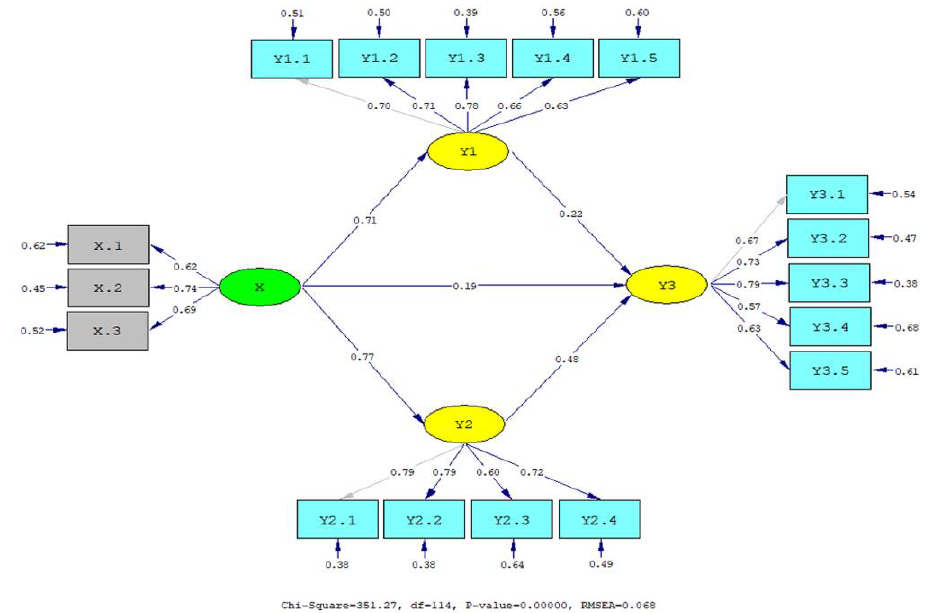
Figure 1. Standardized structural model.